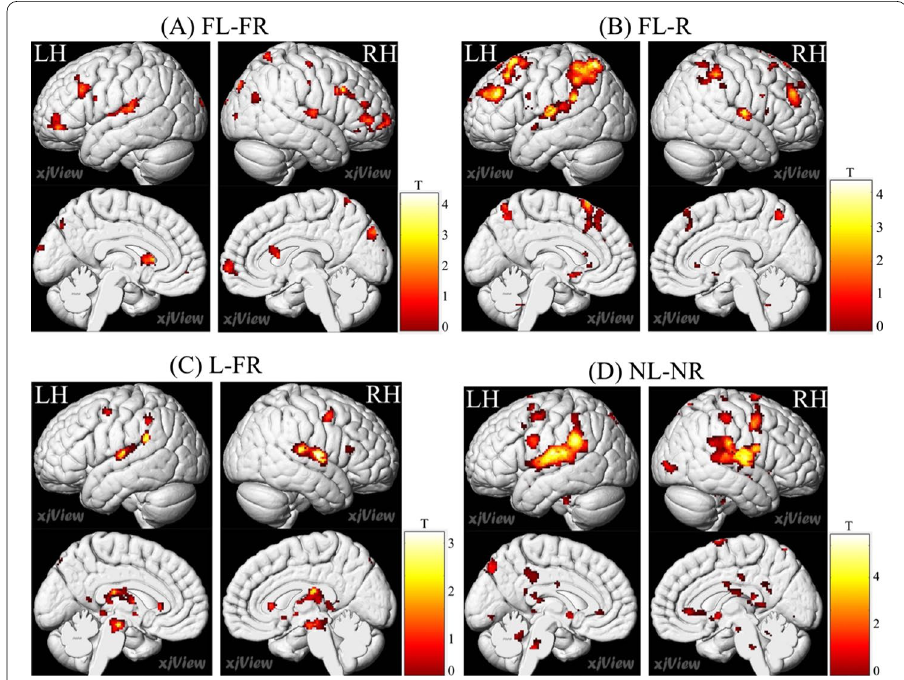
Fig. 7 Brain activation maps for a FL-FR (clusters are thresholded at p < .001, uncorrected), b FL-R (clusters are thresholded at p < .001, uncorrected), c L-FR (clusters are thresholded at p < .03, uncorrected), and d NL-NR stimuli (clusters are thresholded at p < .001, uncorrected). LH, left hemisphere; RH, right